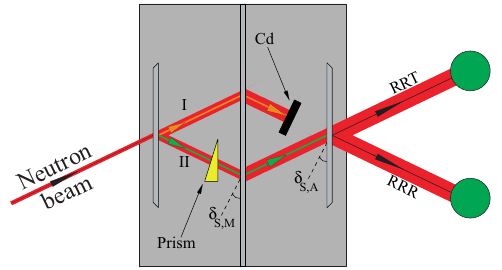
Figure 5. Setup to measure the RR and RRR intensities (Eqs. (8) & (9)) as function of prism angle. Cadmium, 1mm thick, is used to completely absorb path I. The RR intensity is a summation of the outgoing RRT and RRR beams.